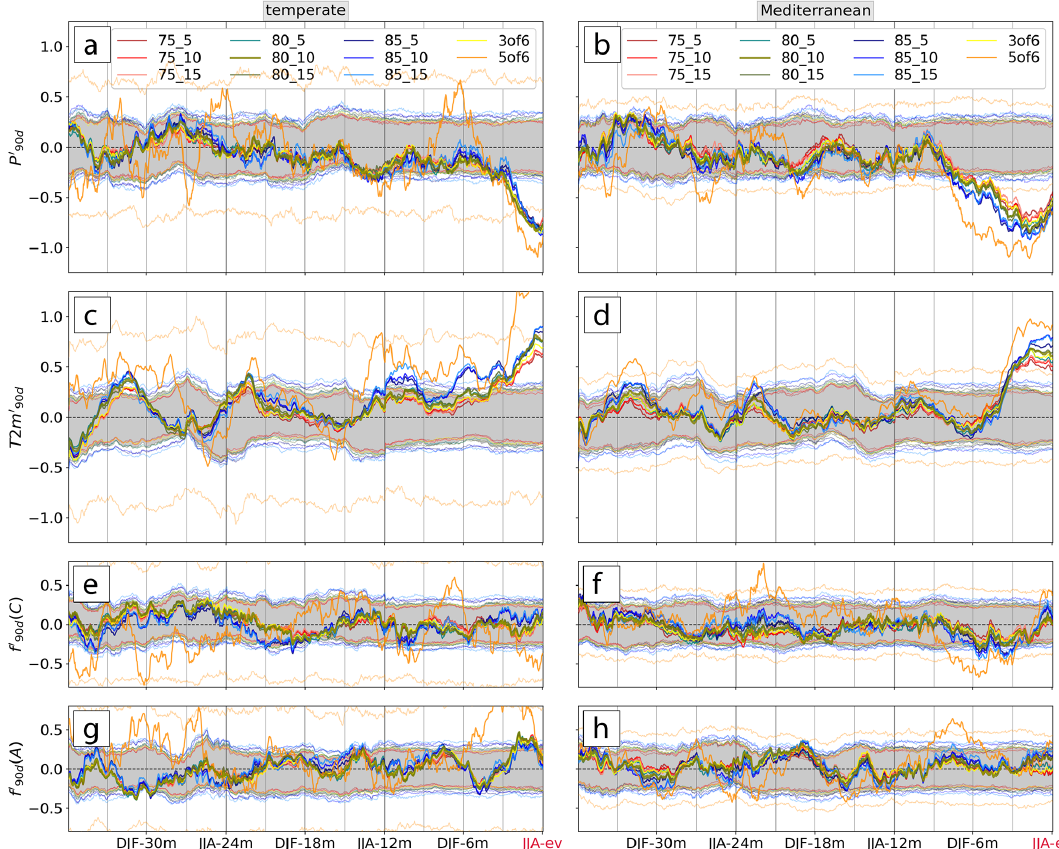
Figure A1. The same as Fig. 5 but for different combinations of AR min , FA min , and c min ev . The thicker olive line and the shaded grey 95% confidence interval (CI) correspond to the median setup shown in the study (Fig. 5). The other thick lines show the meteorological histories of the other combinations of threshold parameters, and the corresponding CI is shown with thin lines of the same color. The normalized 90d mean (a, b) precipitation, (c, d) temperature, (e, f) cyclone frequency, and (g, h) anticyclone frequency anomalies f (cid:48) respectively, are shown as line plots. The legend indicates the combination of threshold parameters used as in Table A1.